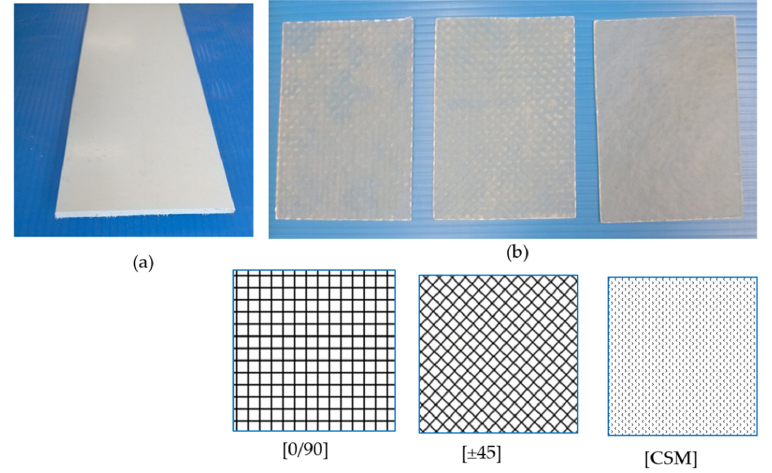
Figure 3. A schematic sectional view of ( a ) PGFRP original material sheet, and ( b ) GFS sheet after mound.